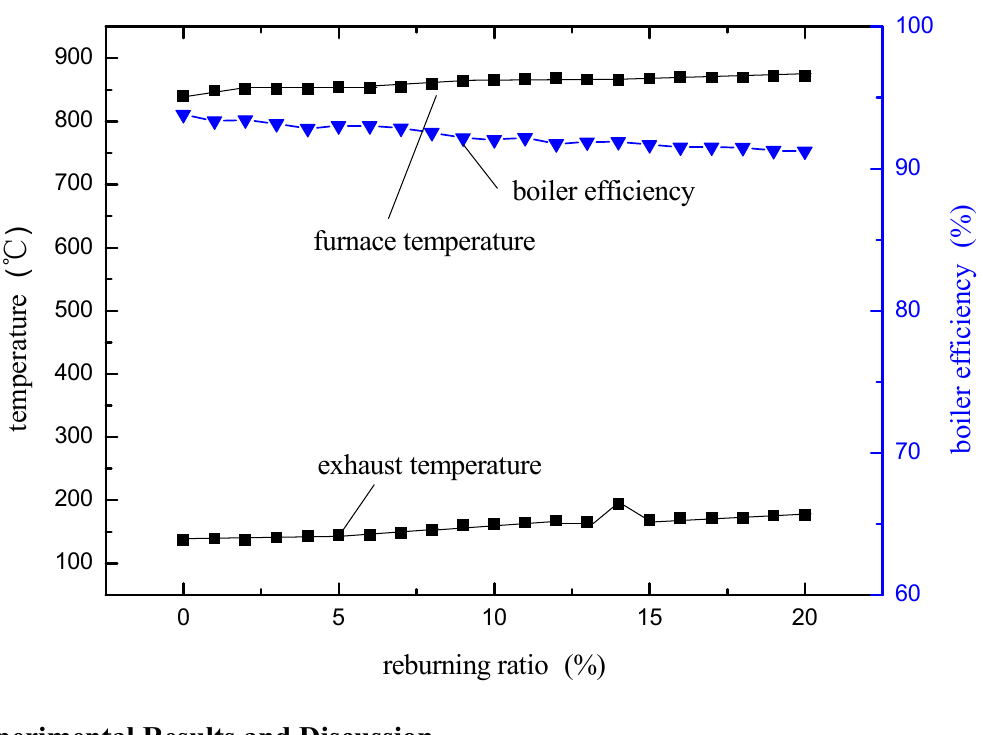
Figure 6. Influence of reburning ratio on furnace temperature, flue gas temperature and boiler efficiency.